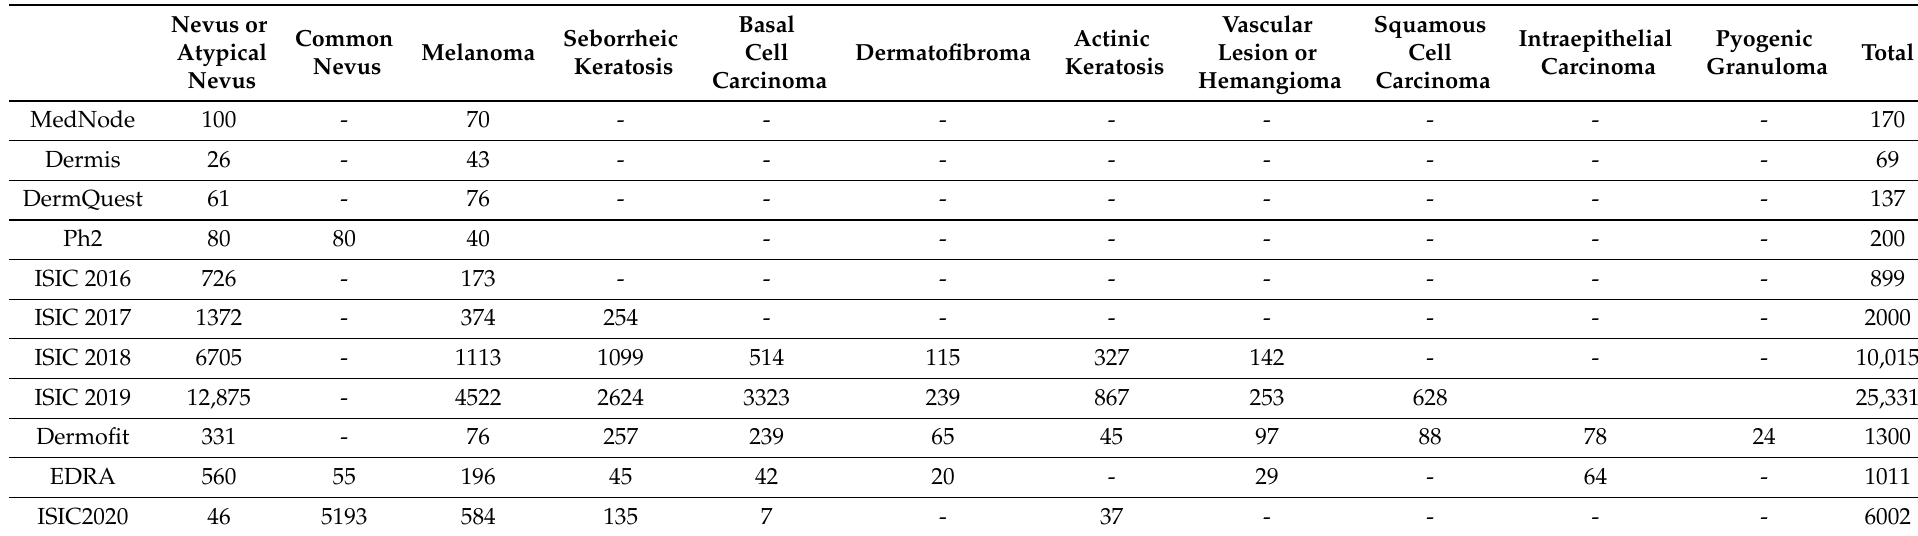
Table 1. Summary of all the discussed